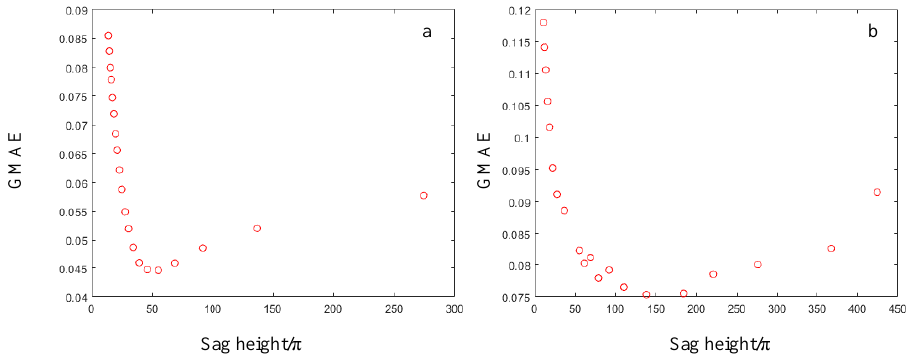
Figure 6. Analysis of global mean absolute value error (GMAE) of different sag heights for a rectangular mask ( a ) and characters “CIST” mask ( b ).